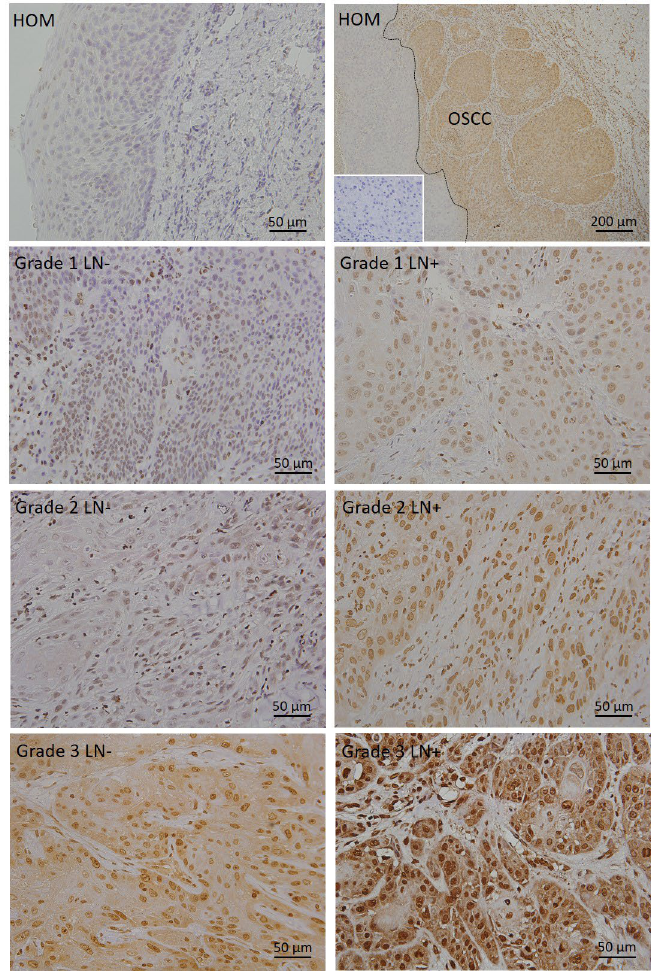
Figure 1. Representative photomicrographs showing megalin immunohistochemical staining in healthy oral mucosa (HOM) and in primary OSCC tissues of different grades (grades 1 to 3), obtained from patients without lymph node metastases (LN − ) and patients whose lymph nodes were affected with metastases (LN+) at the time of diagnosis. The inset represents the negative control.